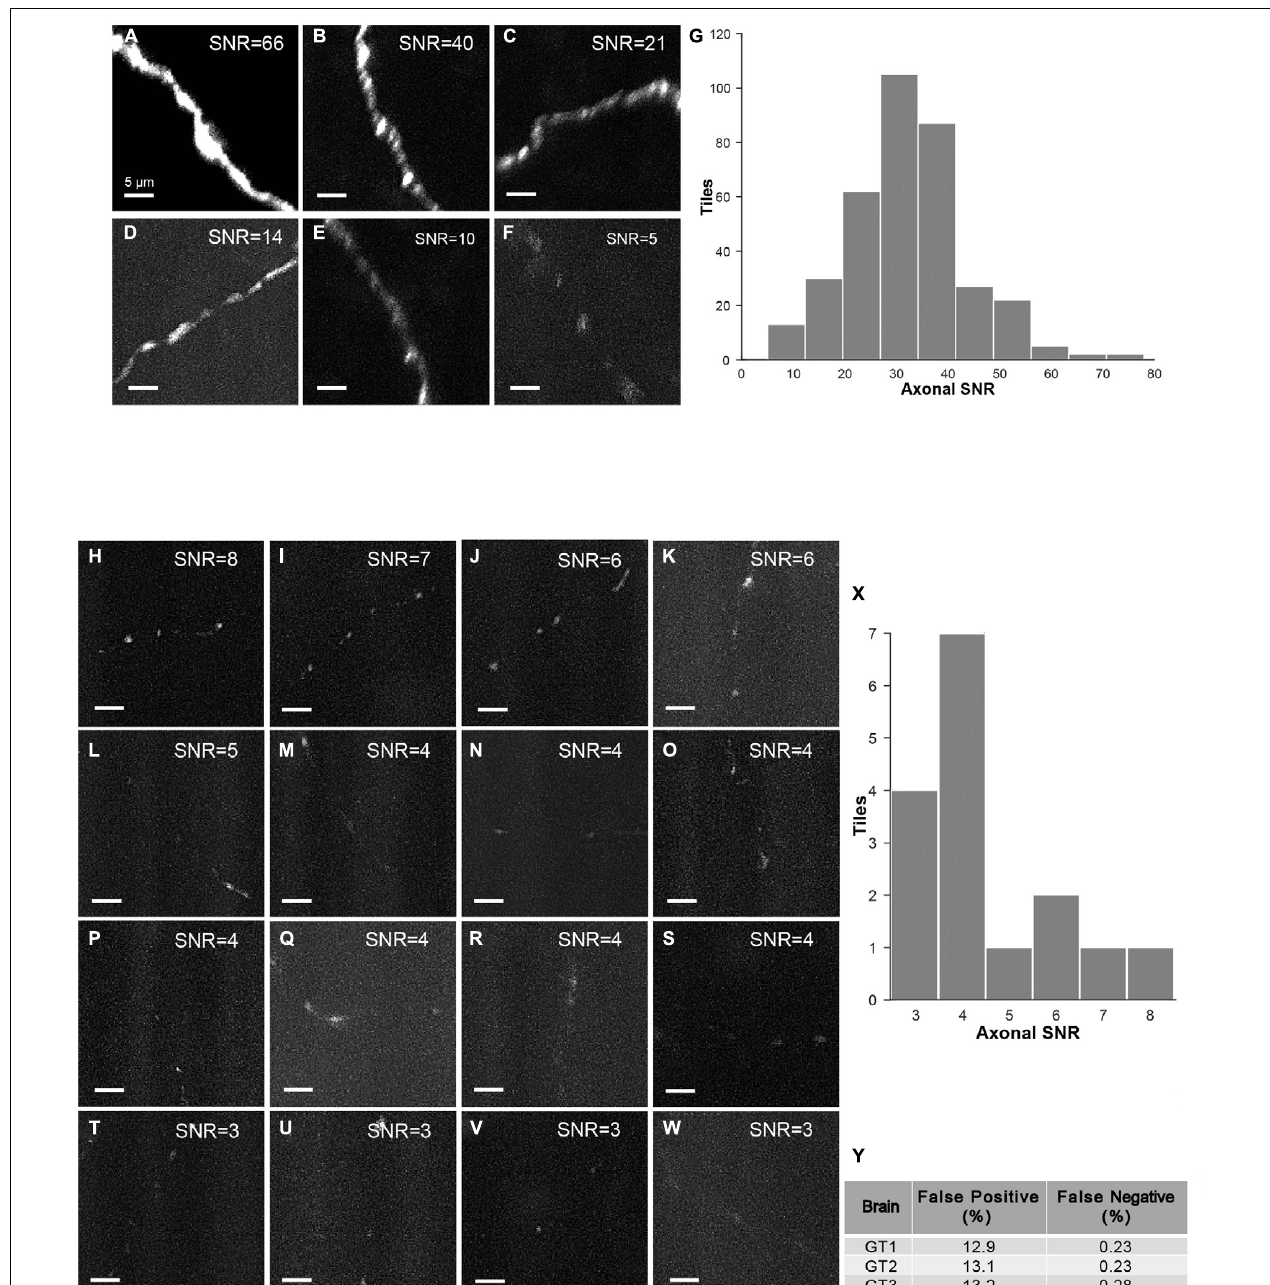
FIGURE 15 | Characterization of false-positive and false-negative rates. (A–F) Axons in randomly selected tiles (maximum intensity projected) from three ground-truth brains. (G) Histogram of SNR of randomly selected tiles with signals ( n = 355). (H–W) Axons in false-negative tiles. Signals in these tiles have very low SNR. (X) Histogram of SNR of false-negative tiles from three ground-truth brains (total tile number = 16). (Y) Characterization of false positive rate and false negative rate in three ground-truth brains (GT1, GT2, and GT3). Scale bars, 5 µ m (A–F,H–W)